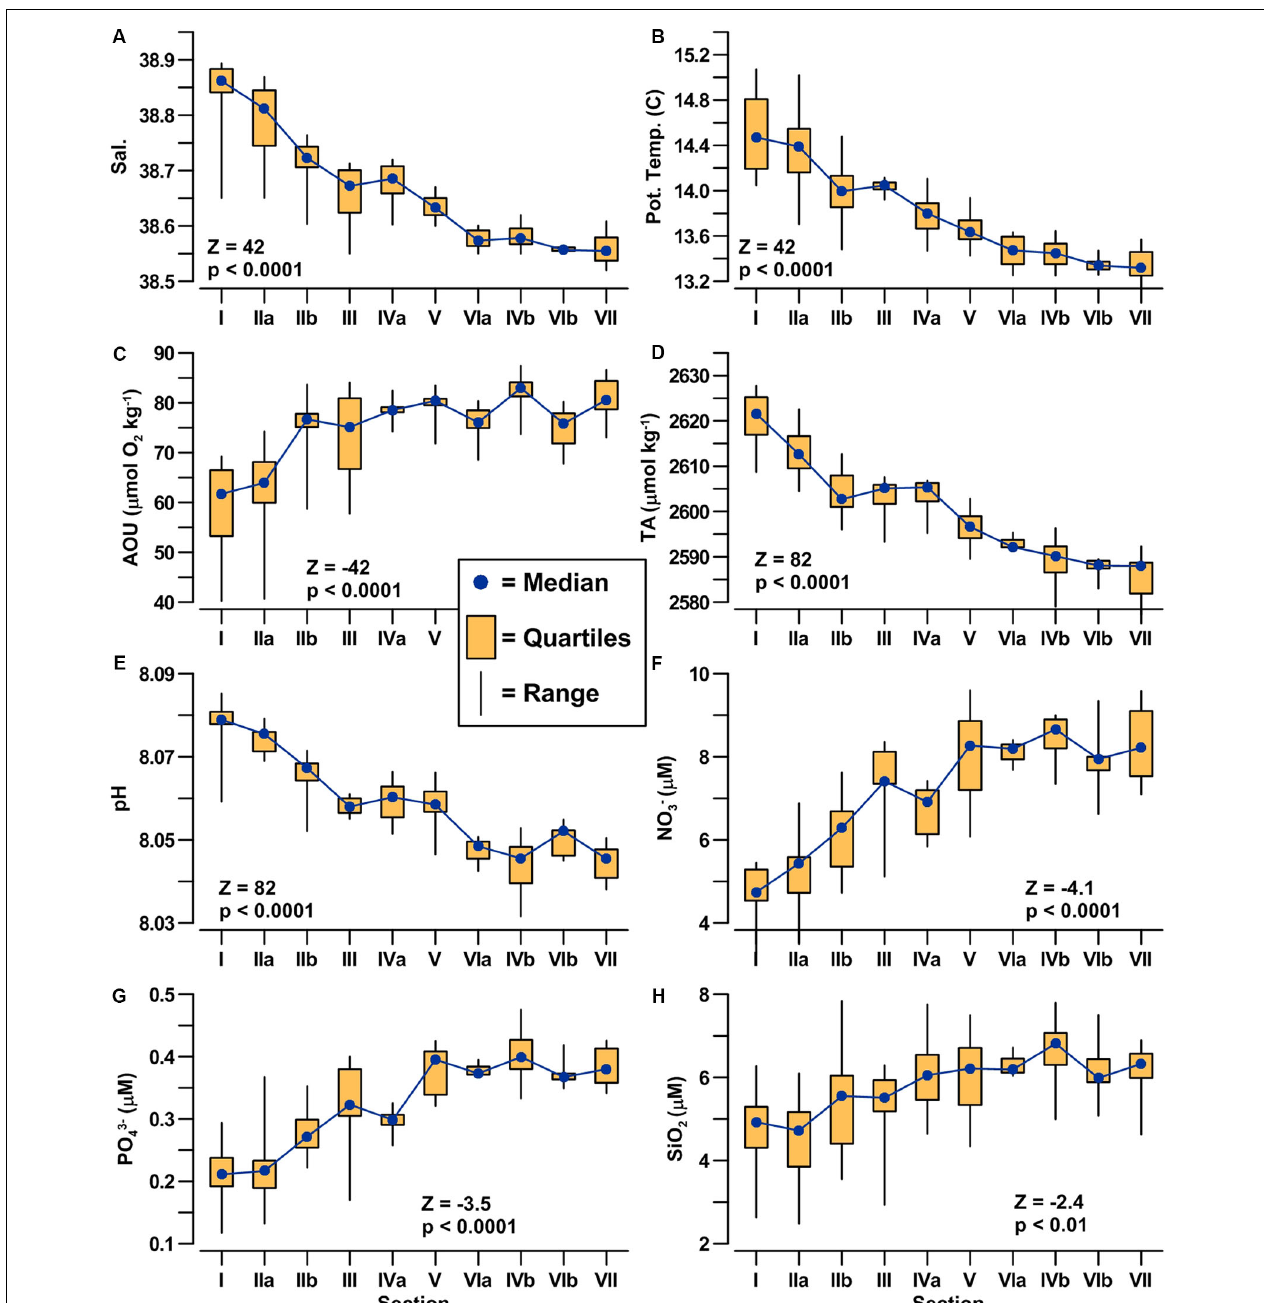
FIGURE 3 | Box-Whisker plots (median, quartiles, range of values) of IW properties in the subregions defined in Figure 1 . The significance of the changes between the subregions I and VII (Mann–Whitney U test; Z value, probability) is also shown. (A) Salinity, (B) potential temperature, (C) apparent ocygen utilization, (D) total alkalinity, (E) pH, (F) nitrate, (G) phosphate, and (H)